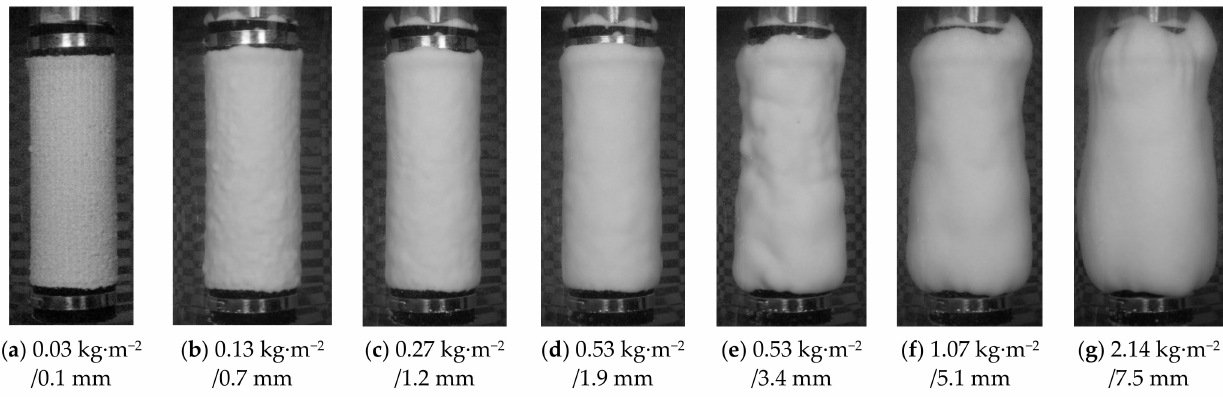
Figure 8. Resultant cake thickness at time t 0 with ascending area